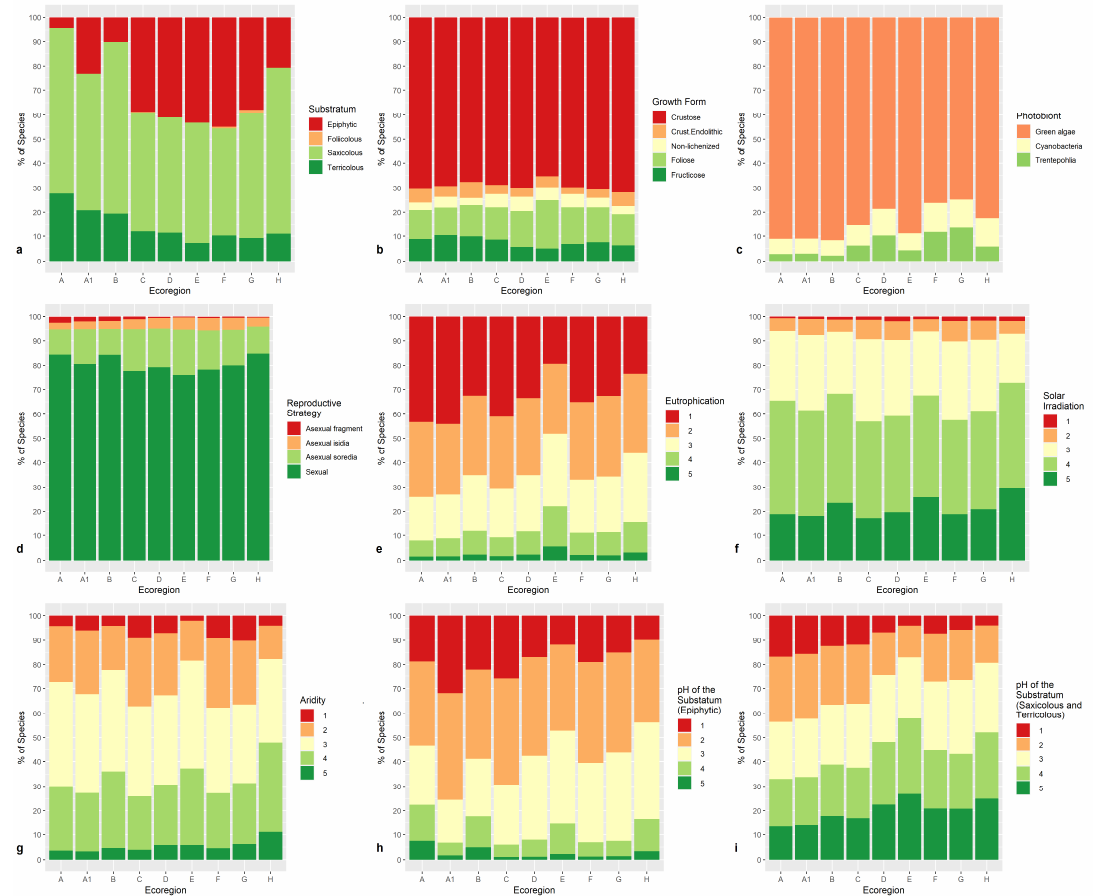
Figure 9. Bar-plot graphs depicting the distribution of lichen taxa per substratum ( a ), growth form ( b ), photobiont ( c ), reproductive strategy ( d ), along with the values of the indicator of eutrophication (from 1—no eutrophication, to 5—very high eutrophication) ( e ), light (from 1—in very shaded situations, to 5—in sites with very high direct solar irradiation) ( f ), aridity (from 1—hygrophytic, to 5, very xerophytic) ( g ), and pH of the substratum (from 1—very acid substrata, to 5—basic substrata) for epiphytic ( h ), and terricolous and saxicolous taxa ( i ) in the OGUs of the 9 ecoregions: Alpine (A), Subalpine (A1), Oromediterranean (B), Montane (C), Dry Submediterranean (D), Padanian (E), Humid Submediterranean (F), Humid Mediterranean (G), Dry Mediterranean (H). Similar colors of the bars depict ecoregions occupying the same altitudinal range. Color codes are green (high-altitude ecoregions), yellow (Montane ecoregion), orange (Submediterranean ecoregions), and red (Mediterranean ecoregions).